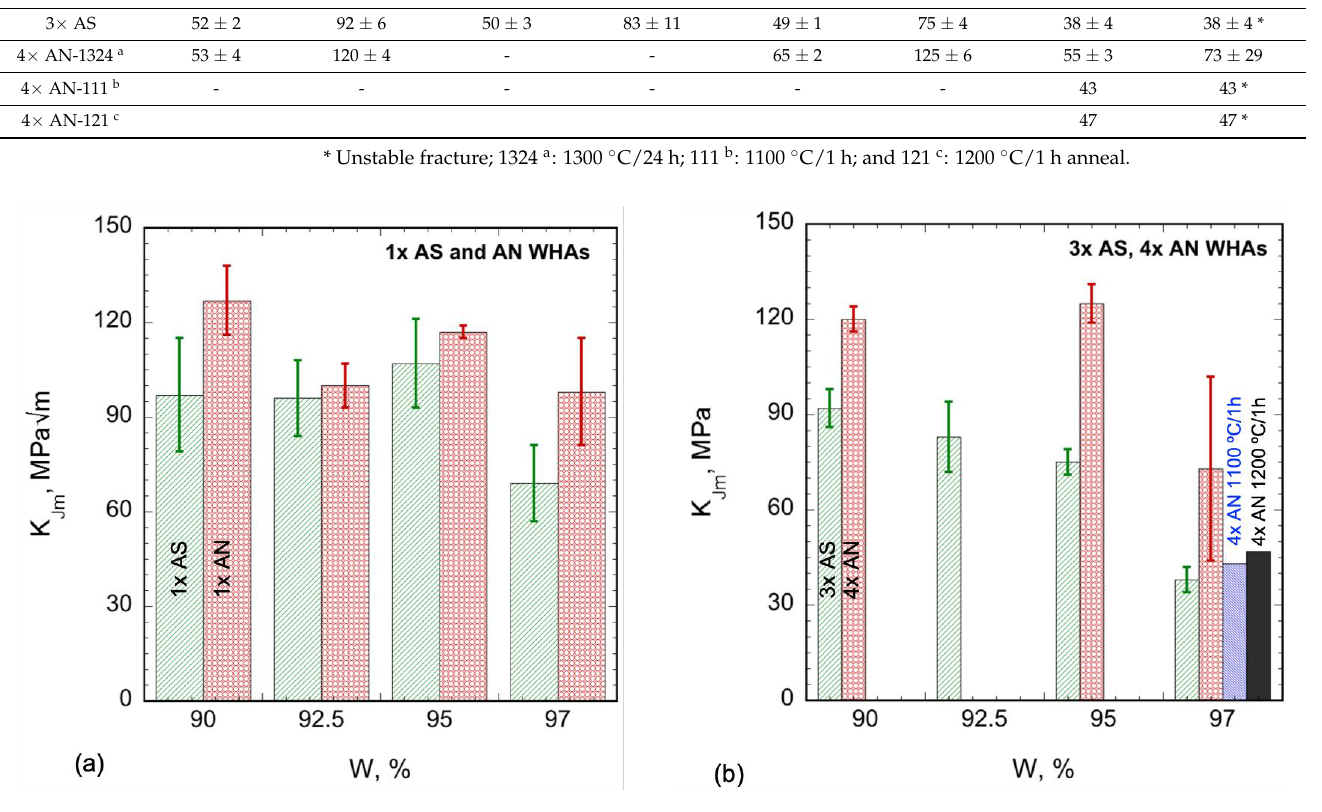
Table 4. RT maximum load fracture toughness (K Im and K Jm, in MPa